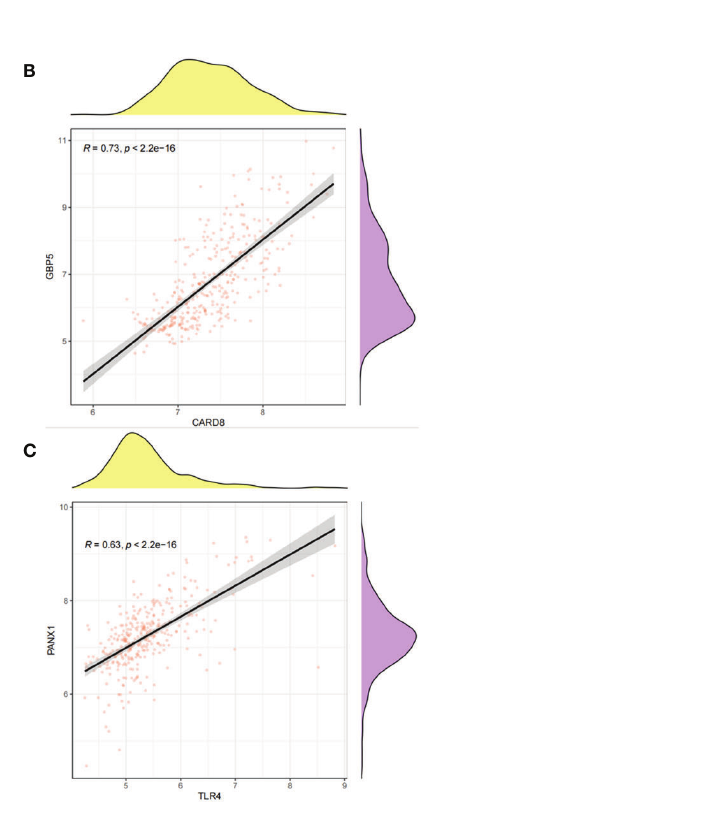
FIGURE 3 Correlations between the expressions of 25 NLRP3 in fl ammasome-related genes. (A) Correlation plot showing signi fi cant correlations between the genes. Purple: positive correlation. Yellow: negative correlation. Circles with deeper colors indicate stronger correlations. (B) Correlation between CARD8 and GBP5 expressions in integrated samples. (C) Correlation between TLR4 and PANX1 expressions in diseased